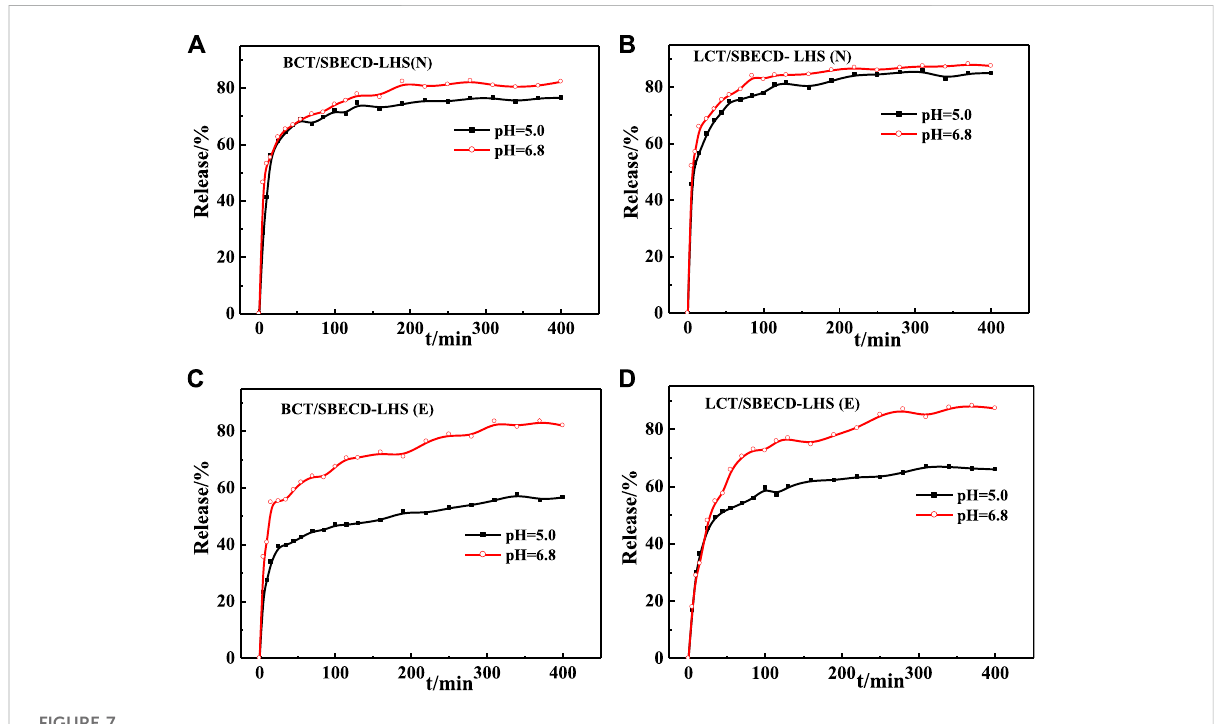
FIGURE 7 Release curves of pesticides from LHS-hybrids in different